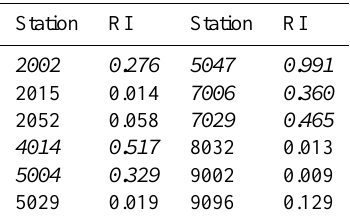
Table 2. Maximum (present) reservoir index (RI) for the flow gauge stations under altered regime (high altered stations in